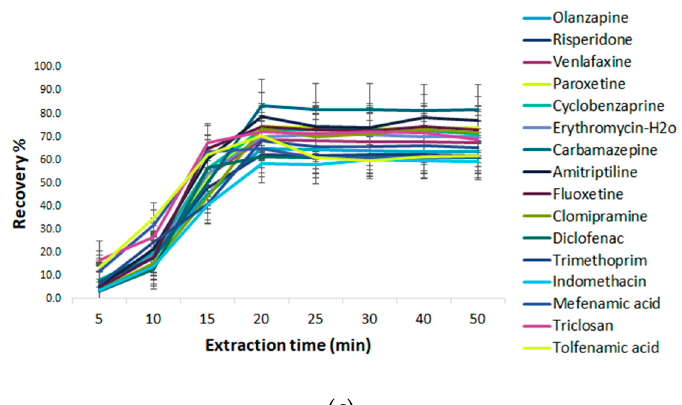
Figure 8. Effect of the extraction parameters of MSPE@C18 ( a ) pH, ( b ) amount of GO@Fe 3 O 4 , and ( c ) extraction time. Amount of Fe 3 O 4 @SiO 2